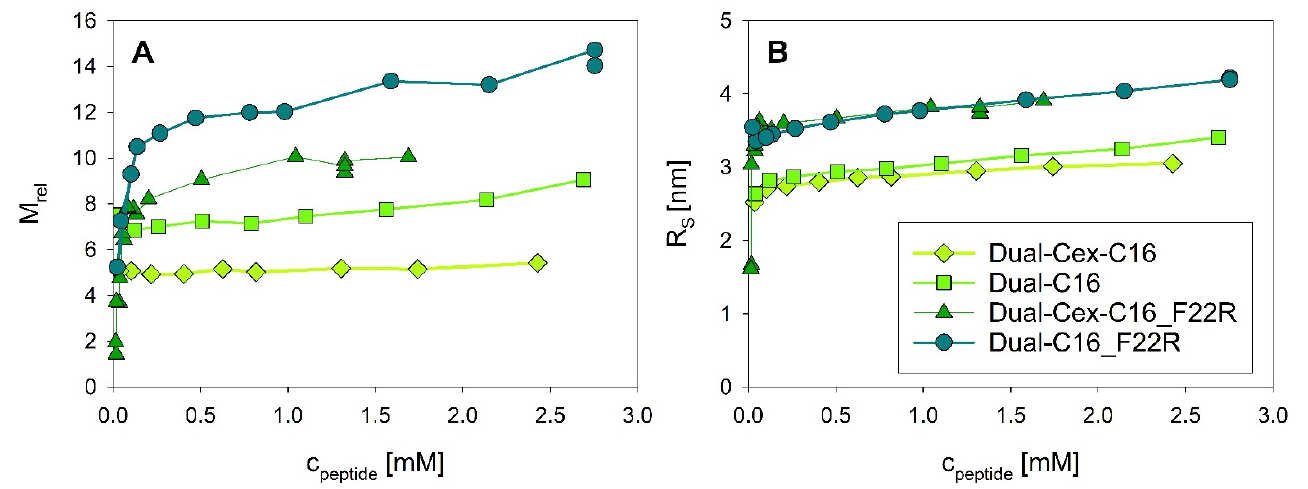
Figure 8. Association equilibria of palmitic acid conjugated Dual-Cex and derived variants. Relative molecular masses M rel ( A ) and Stokes radii R S ( B ) were measured at 23 °C in PBS at pH 7.4. The according data for Dual-Cex-C16 and Dual-C16 were previously published [4] and are shown for contextual reasons.